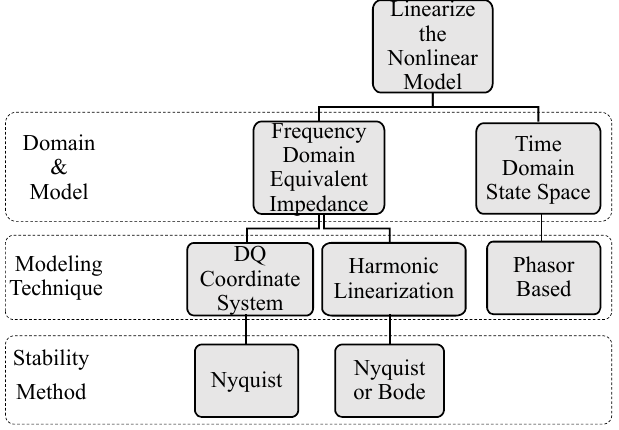
Figure 3. Different SSSA Methods in AC System by Linearizing the Non-linear